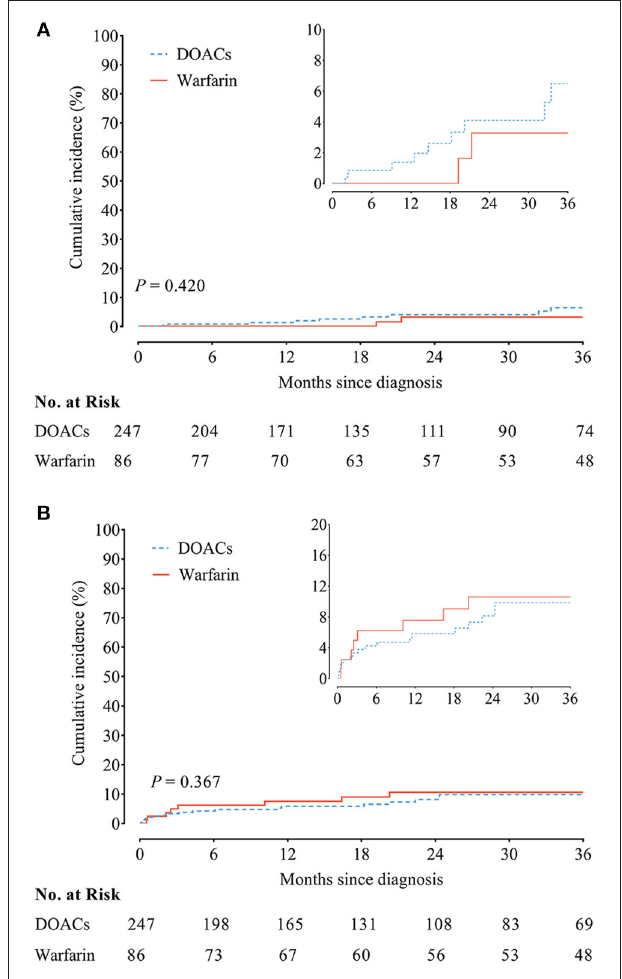
FIGURE 2 | (A) Recurrent venous thromboembolism (VTE) and (B) clinically relevant bleeding between chronic thromboembolic pulmonary hypertension (CTEPH) patients treated with direct oral anticoagulants (DOACs) and